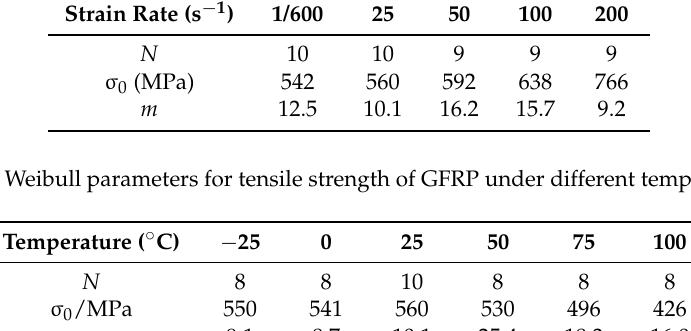
Table 4. Weibull parameters for tensile strength of GFRP under different strain rates.